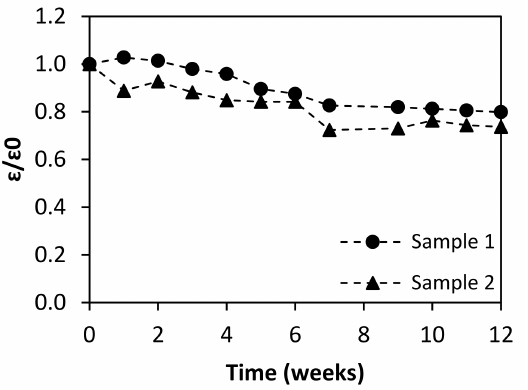
Figure 3. Thickness profile measured for the two immersed polymeric membranes along the 12 weeks of aging ( ε —thickness at any time during the aging procedure; ε 0 —thickness at the beginning of the aging procedure).